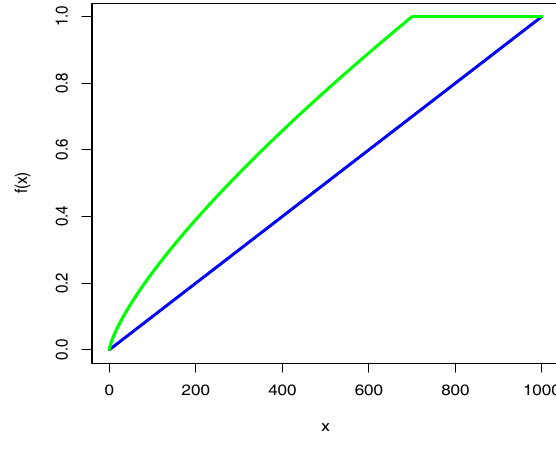
Figure 1. Weighting functions.